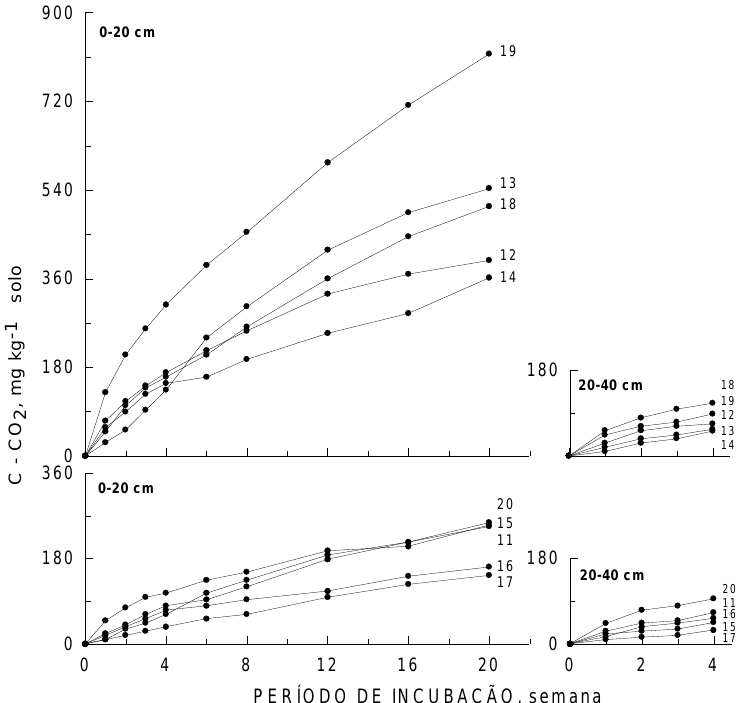
Figura 4. Mineralização acumulada de carbono (C - CO solos da zona semi-árida de Pernambuco, incubadas por 20 e 4 semanas,